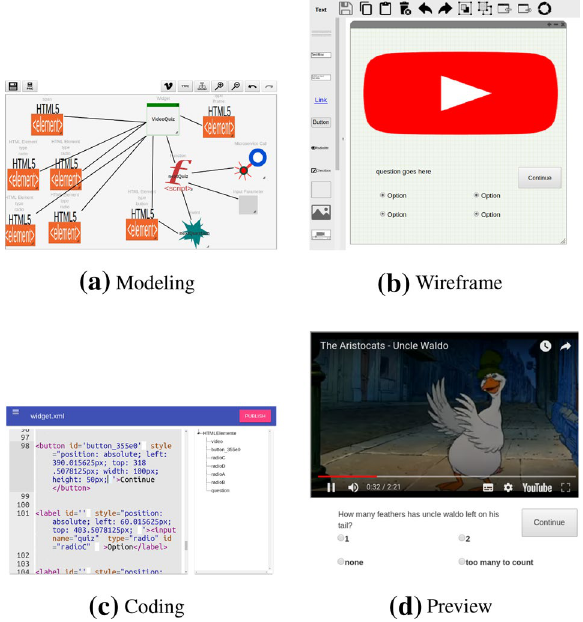
Fig. 3 Different representations of the same frontend